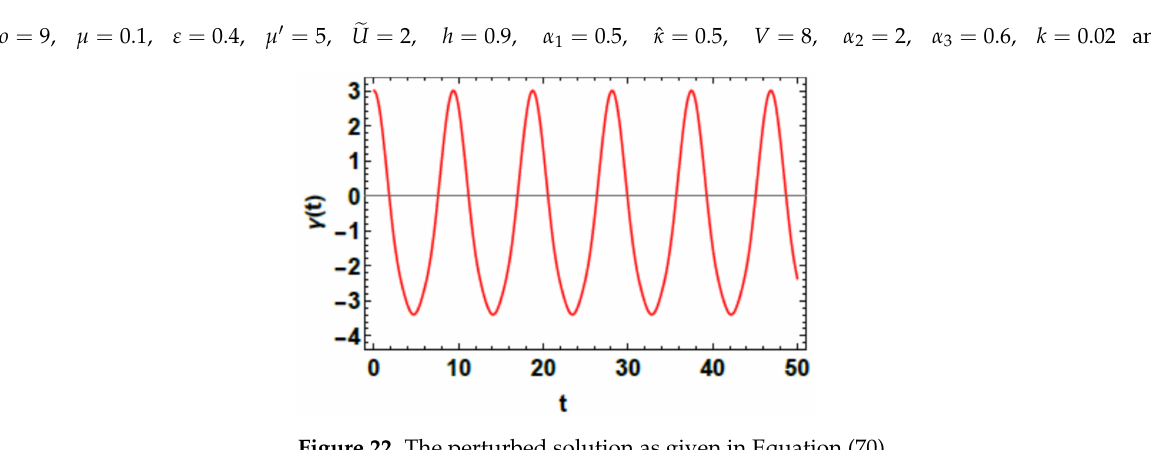
Figure 22. The perturbed solution as given in Equation (70).